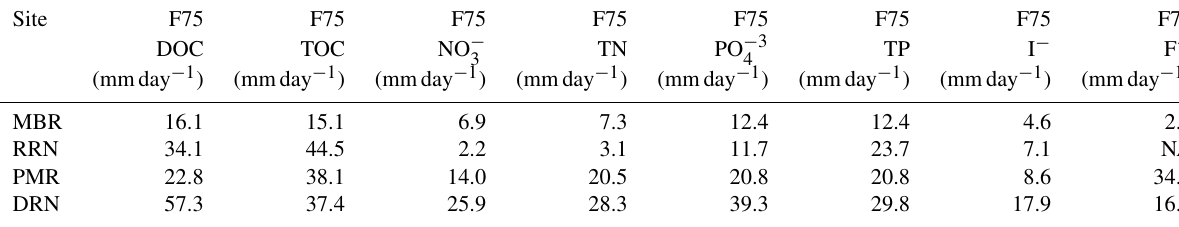
Table 5. F75 metric: the runoff below which 75% of nutrients are exported.